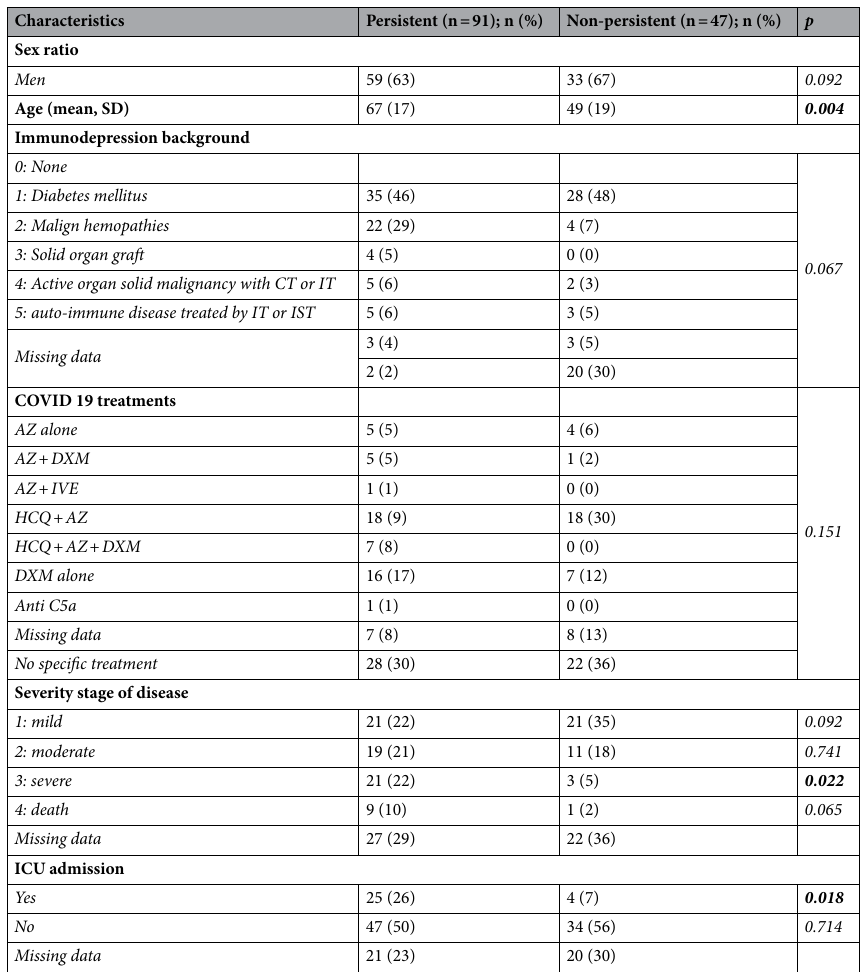
Table 1. Characteristics of patients. IT: immunotherapy; IST: immunosuppressive therapy; AZ: azithromycin; DXM: dexamethasone; HCQ: hydroxychloroquine; IVE: ivermectin; ICU: intensive care unit. Significant values are in bold and